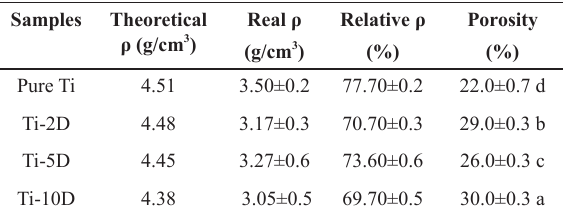
Density and porosity of samples.